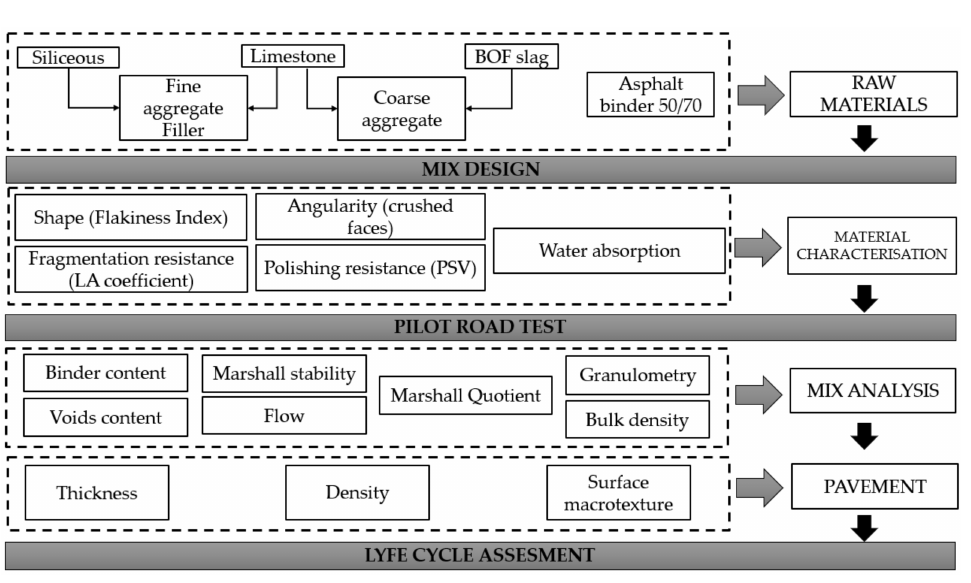
Figure 1. Experimental design program (LA: Los Angeles coefficient; PSV: Polished Stone